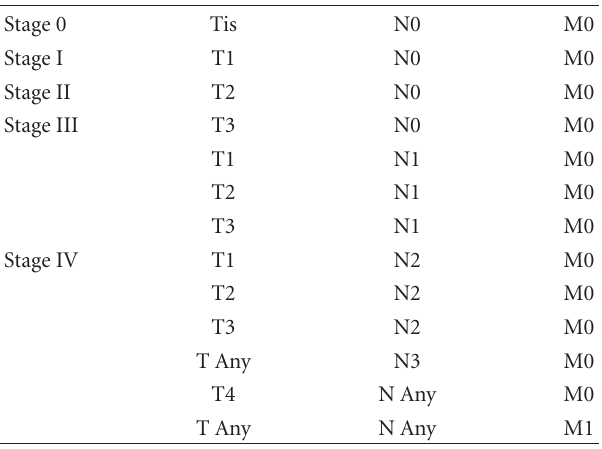
Table 5: Anatomic stage/prognostic